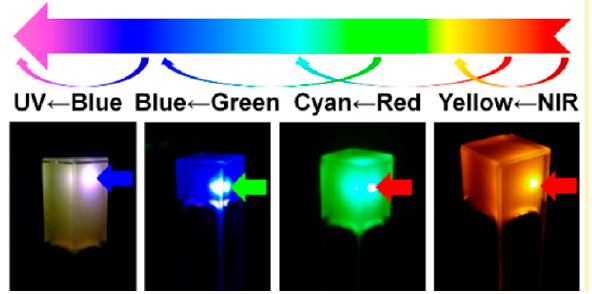
Figure 7. A series of organogels from Duan et al., who performed photon up-conversion for wavelengths across the visual spectrum (color of incident wavelength shown in arrow) [63].